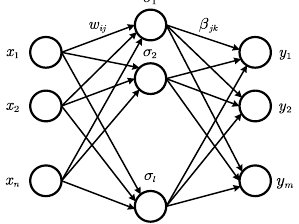
Figure 1 . Structure of